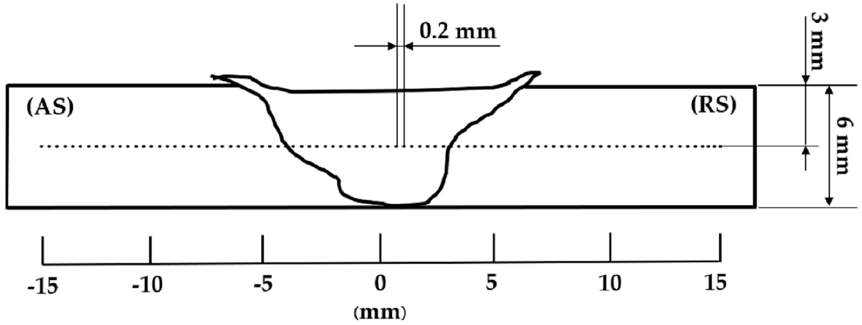
Figure 6. Profile of hardness test positions.